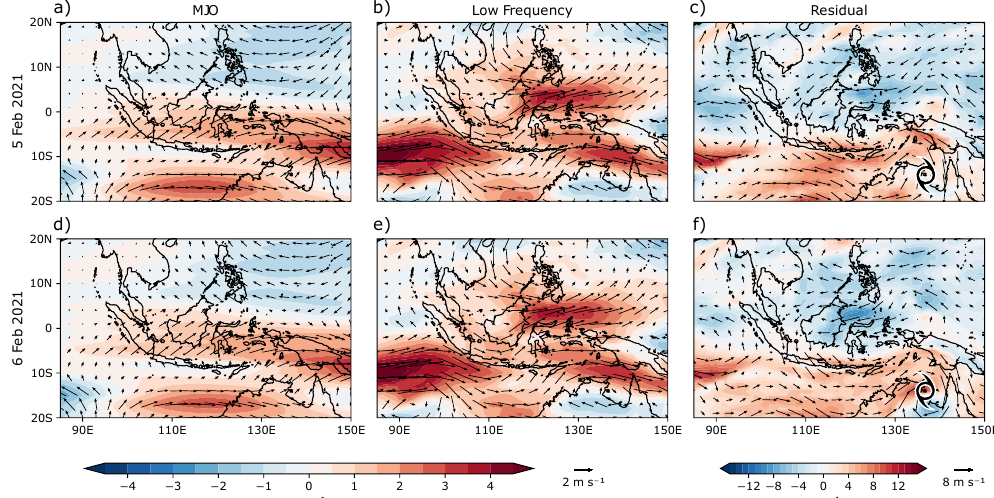
Figure 8. Daily evolution of 850 hPa zonal wind (color shading) and total wind anomalies (vector) anomalies during the Semarang flood event on 5 February 2021 ( a – c ) and on 6 February 2021 ( d – f ). Wind anomalies filtered for ( a , d ) Madden–Julian oscillation (MJO), ( b , e ) the low-frequency oscillation ( > 120 days), and ( c , f ) residuals (total − (MJO + low frequency)). Note that the amplitude used for the residuals is different from MJO and low-frequency